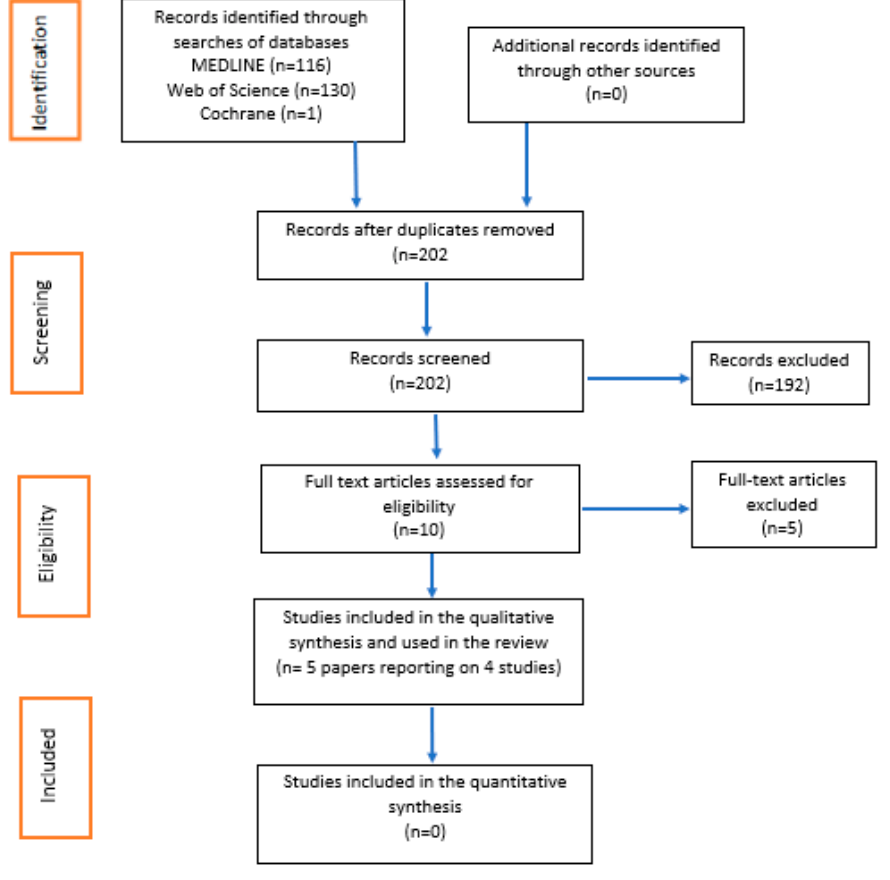
Figure 1. PRISMA flow diagram.